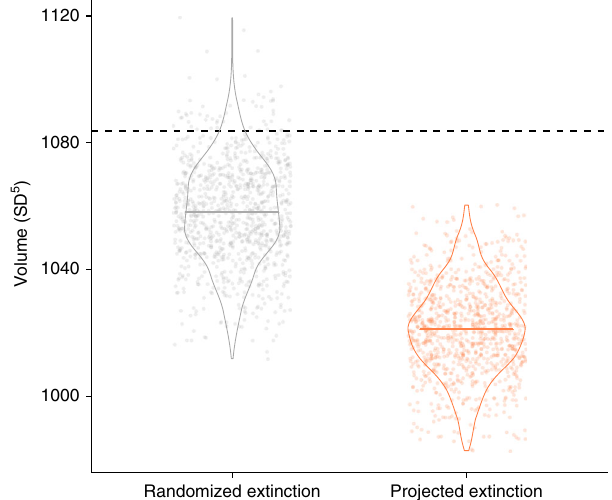
Fig. 3 The ecological strategy space for mammals and birds under 100-year extinction scenarios. The dashed horizontal line indicates the observed ecological strategy space (hypervolume). For both scenarios we include jittered points for each of the 999 replicates, violins of data density and a central thick line of the mean. Due to the stochastic nature of the hypervolume algorithm 32 , the ecological strategy space may increase as species are removed. 1095 mammal and bird species are lost under both the projected and randomized extinction scenarios, re fl ecting the probabilistic extinctions based on the IUCN threat categories (Methods). Source data are provided as a Source Data fi